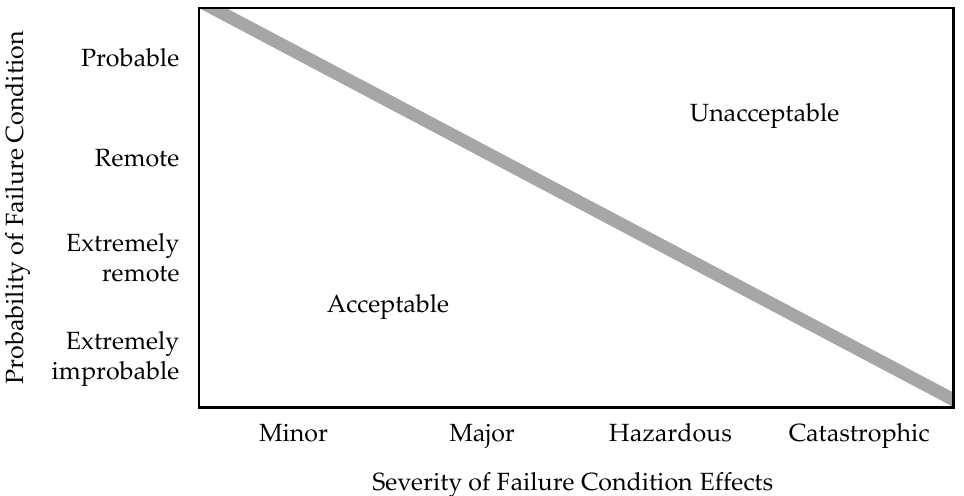
Figure 6. Relation of probability of failure condition to severity of failure condition effects as used in CS 25.1309, adapted from